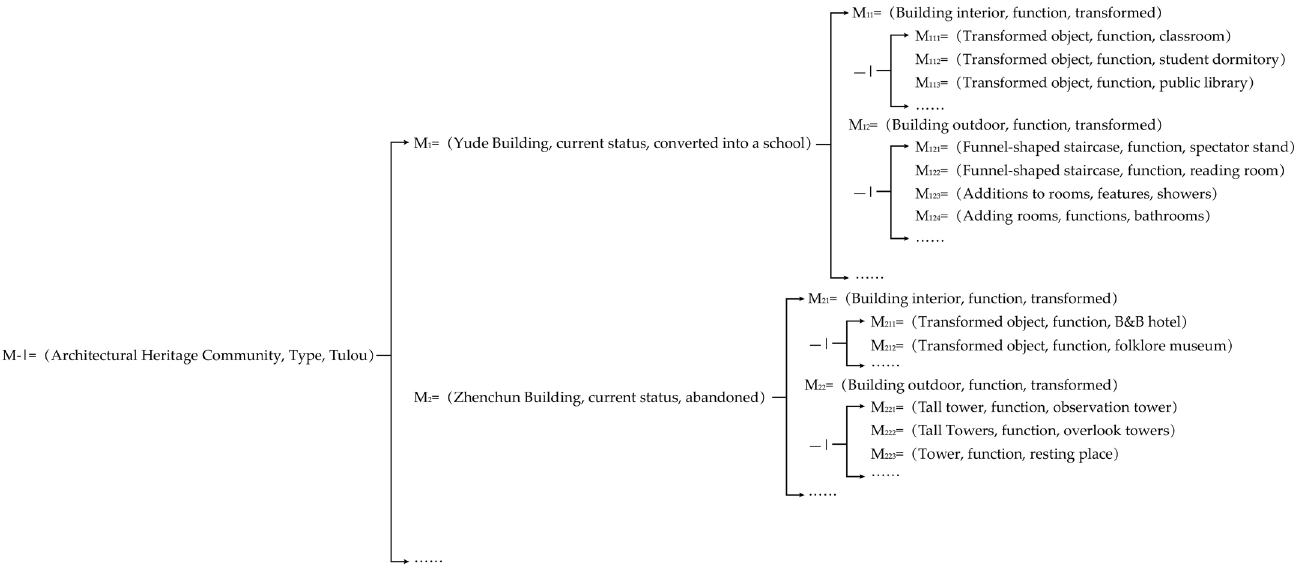
Figure 8. The divergent tree of the Tulou building renovation case.